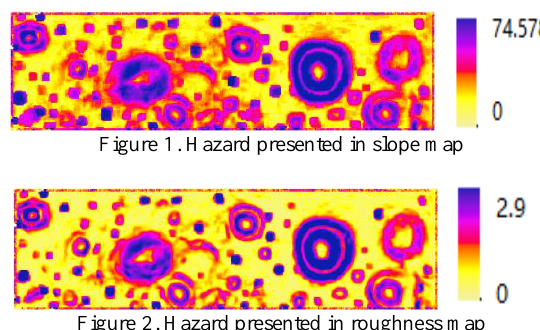
Figure 1. Hazard presented in slope map